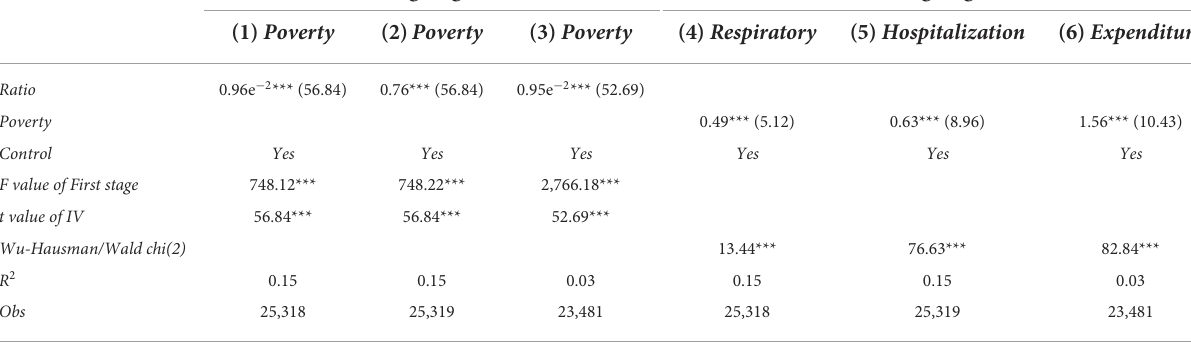
TABLE 3 Energy poverty and health status: Ivprobit & 2SLS.